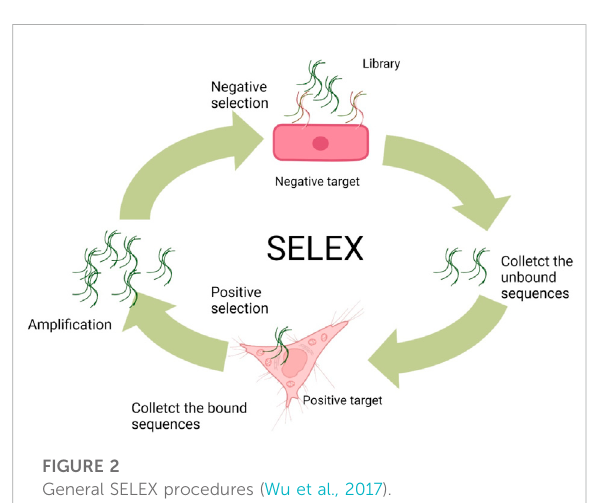
FIGURE 2 General SELEX procedures (Wu et al.,